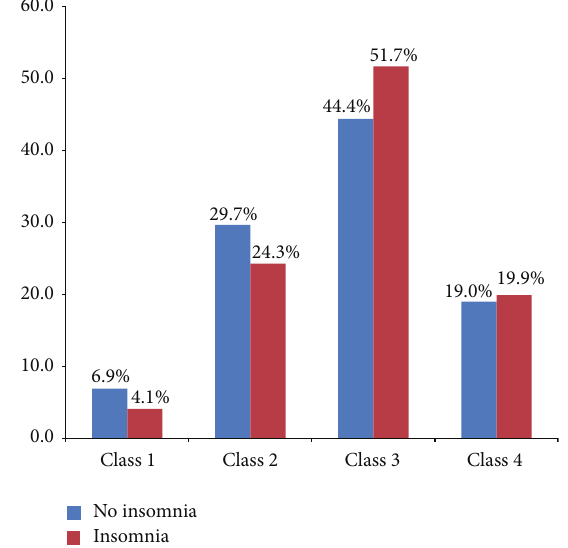
Figure 1: Oropharyngeal crowding (Mallampati classification) by prevalence of